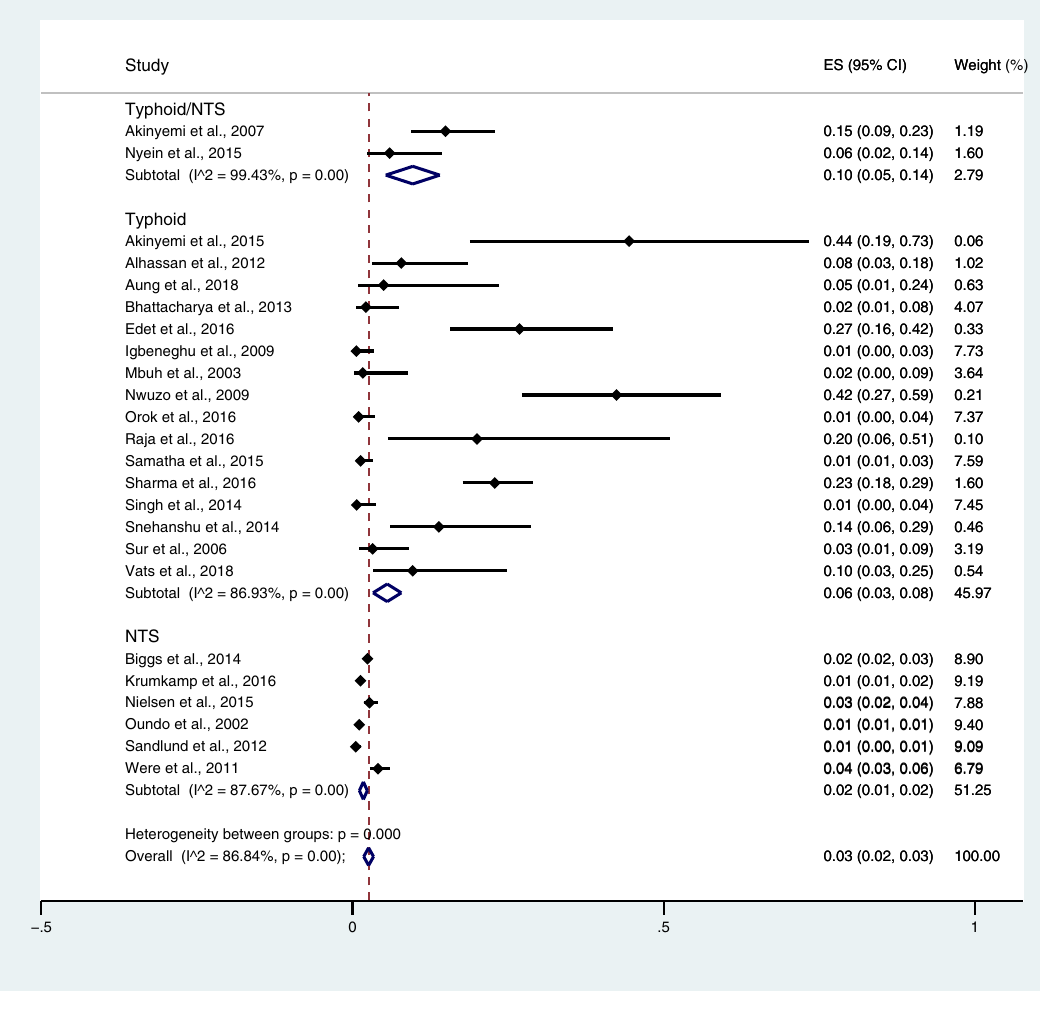
Figure 17. Prevalence of typhoidal/NTS infection among patients with malaria using blood cultures for the identification of Salmonella spp. infection stratified by typhoidal/NTS infection. ES proportion estimate (multiply 100 units for interpreted as prevalence estimate), CI confidence interval, NS not